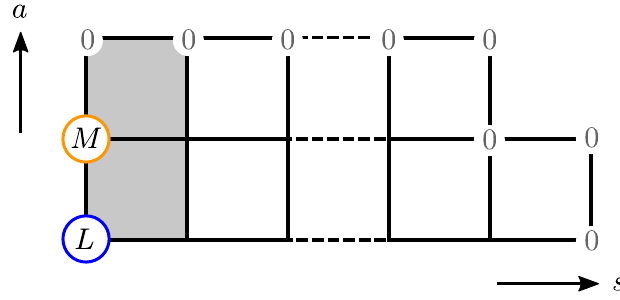
Figure 2 . The Young tableaux associated to the rational Q -system. At each node of the Young diagram we have one Q -function denoted by Q the